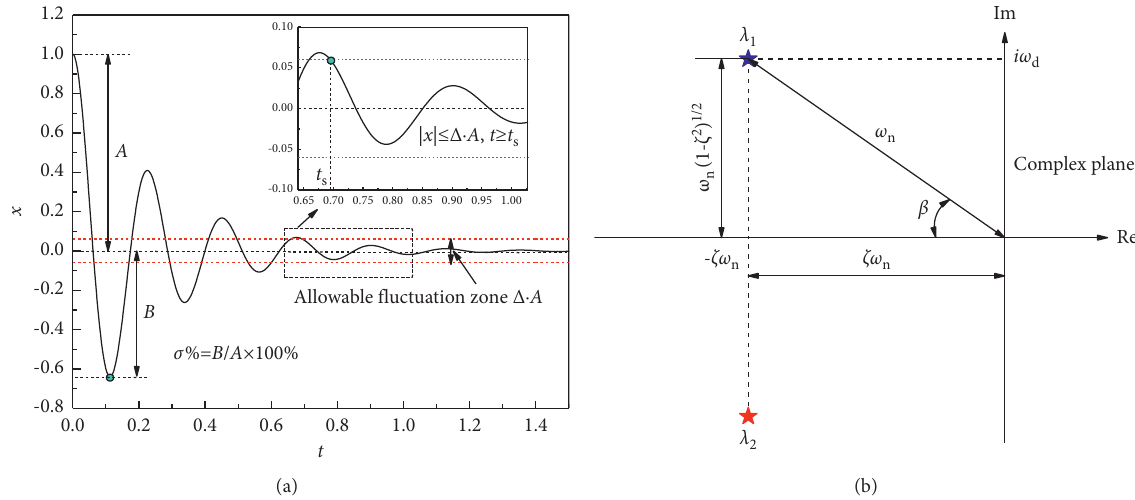
Figure 3: Qualitative analysis of system performance: (a) definition of transient performance parameters and (b) relationship between closed-loop pole position and performance